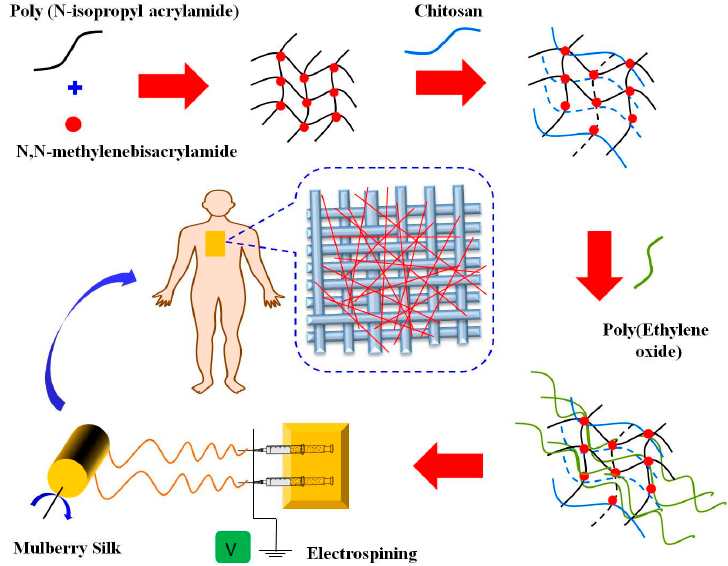
Figure 1. Scheme process of prepared the temperature- and pH-sensitivity mulberry silk fabric.